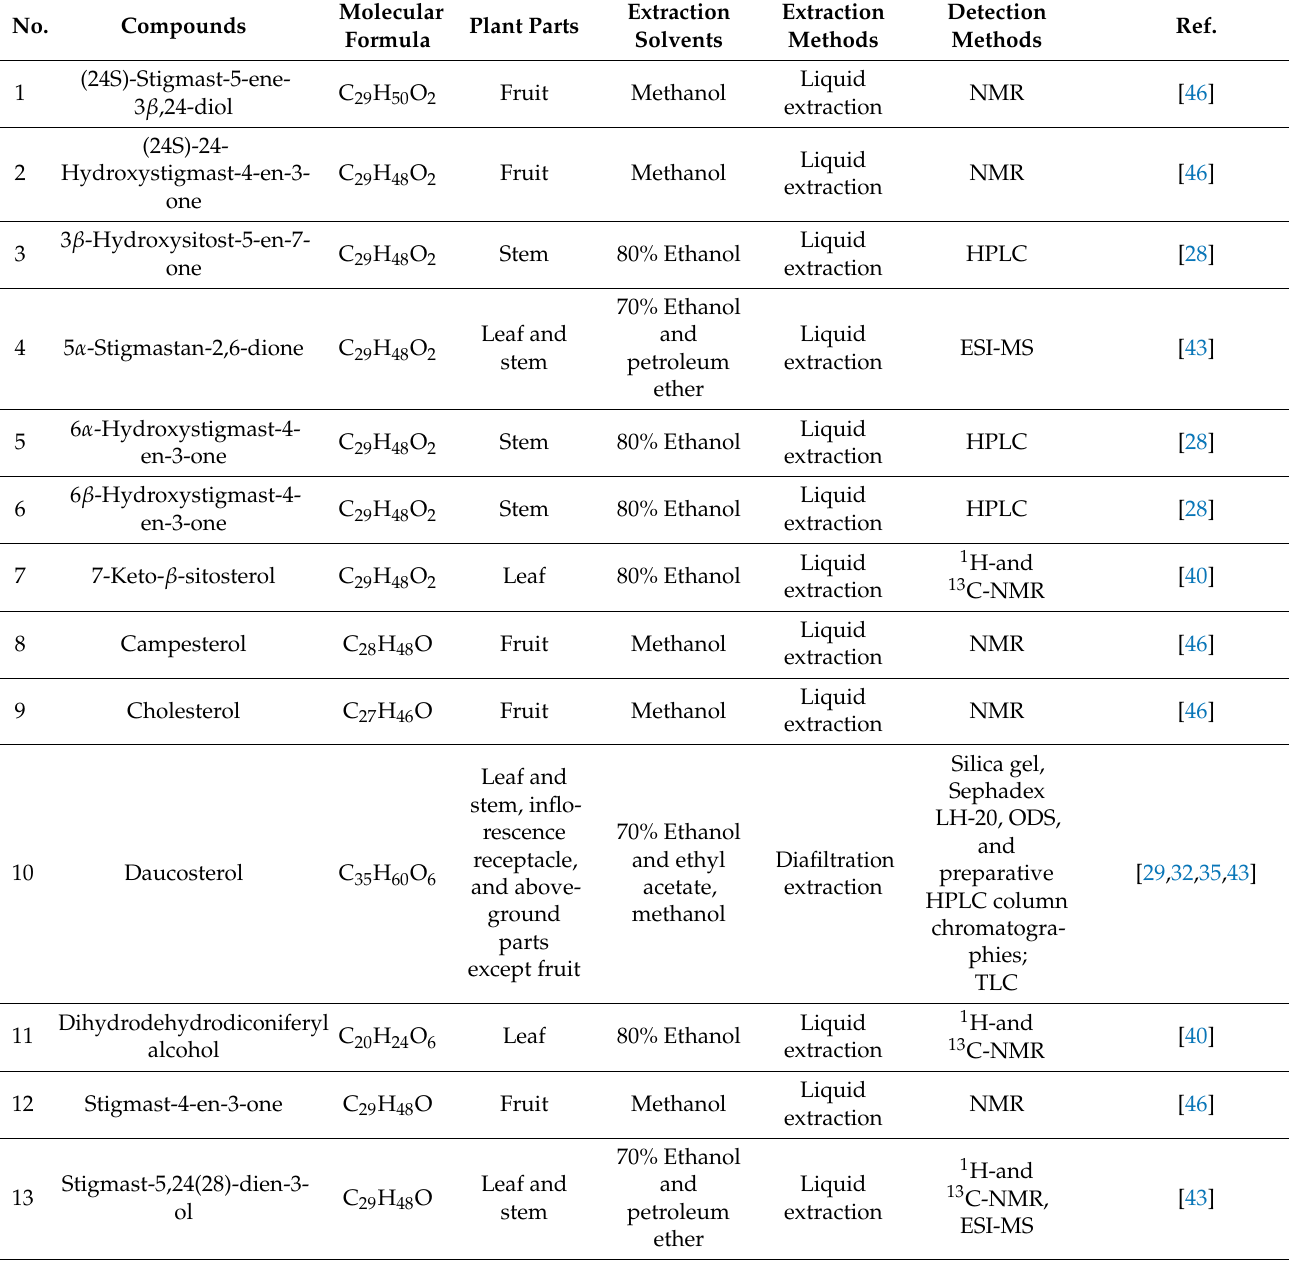
Table 4. Steroid compounds found in Ficus pumila